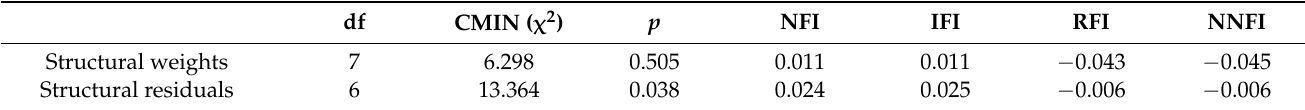
Table 3. Multi-group analysis, model comparisons (testing